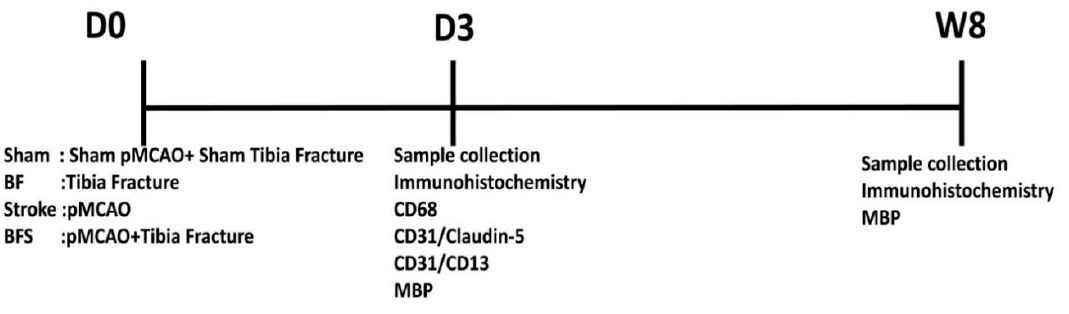
Figure 1. A flow chart illustrating the experimental design. D: day; W: week. CD68 was used as a maker to detect activated microglia and infiltrated macrophages, CD31 for endothelial cells, CD13 for pericytes, claudin-5 for tight-junction protein, and MBP (myelin basic protein) for white matter (WM) measurement.